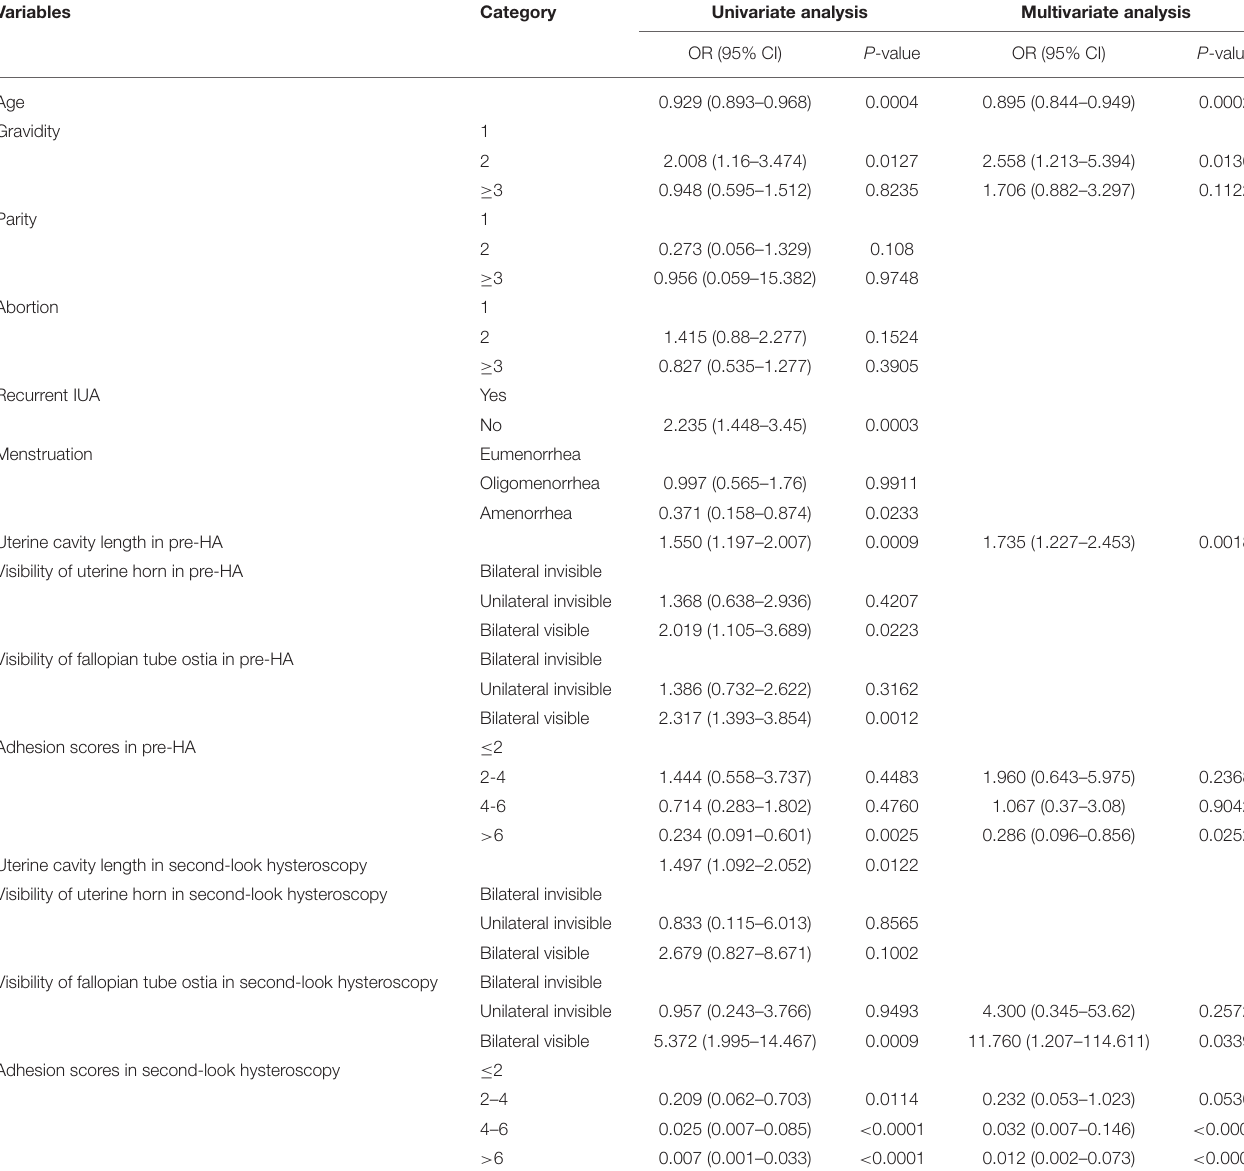
TABLE 2 | Logistic regression analysis of the risk factors for live birth